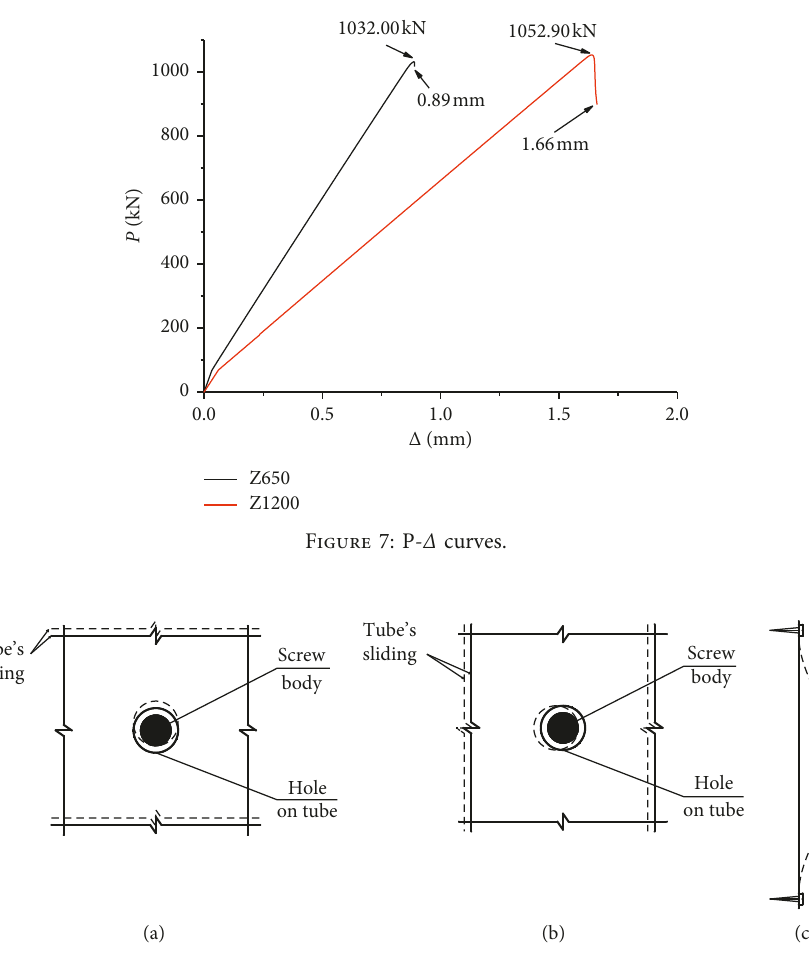
Figure 8: Tube sliding and bugle phenomenon: (a) vertical sliding; (b) lateral expansion; (c) bulge